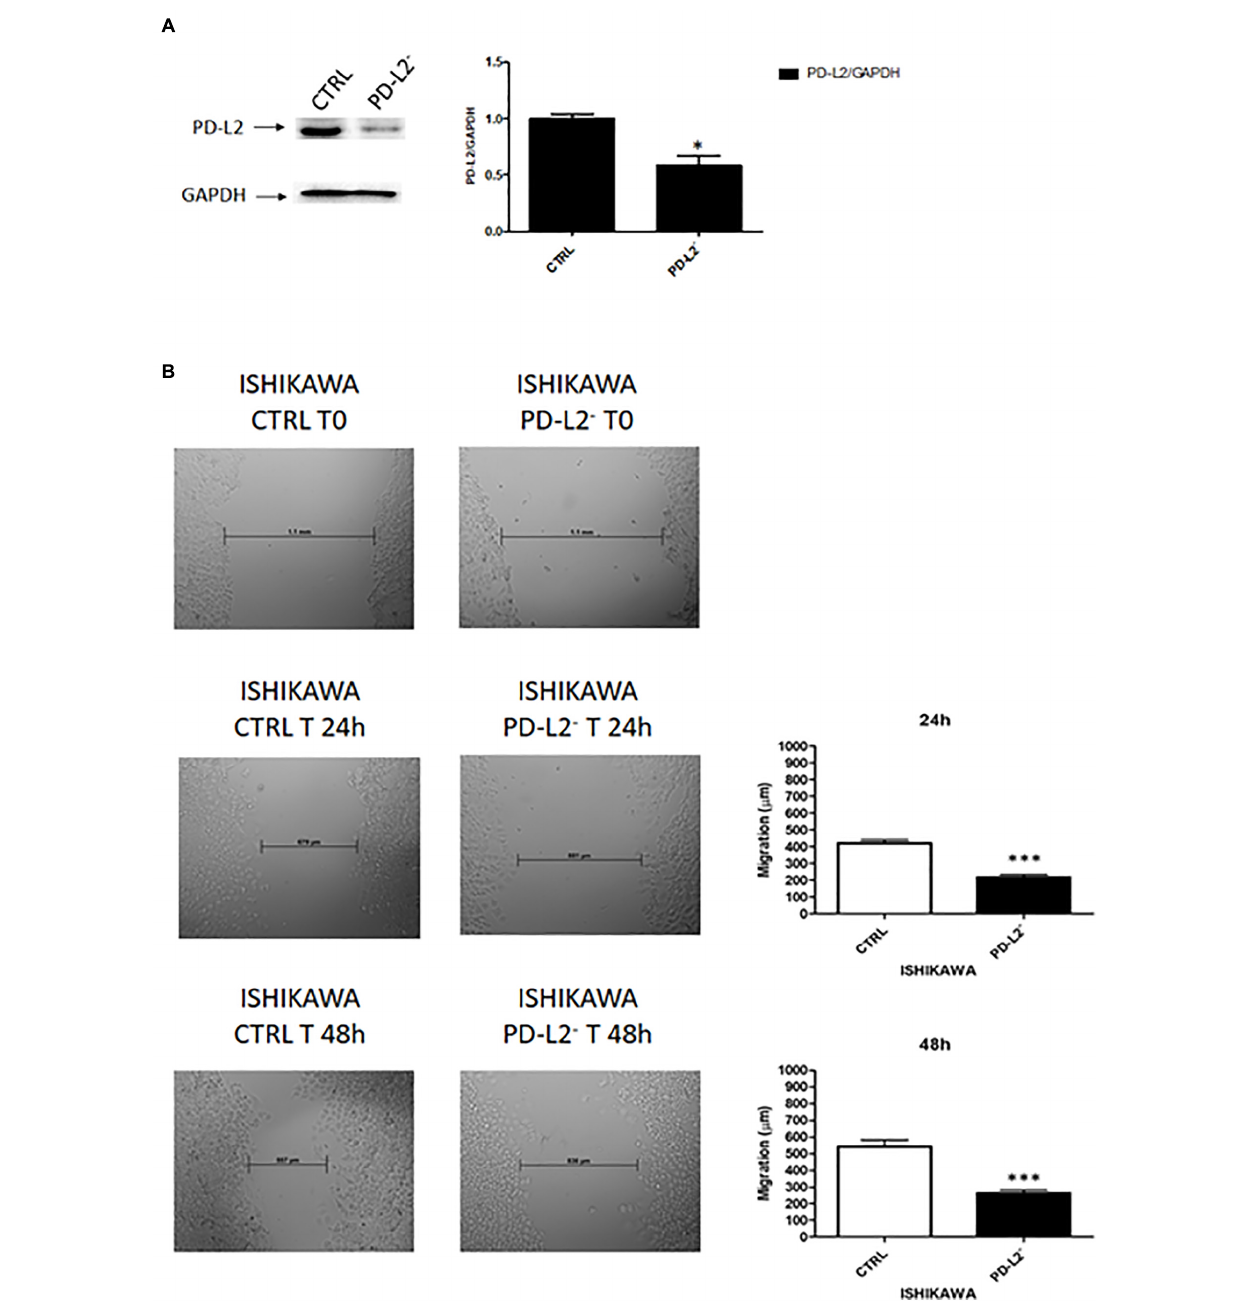
FIGURE 6 | (A) PD-L2 silencing reduces migration in Ishikawa cells. (A) Western blot analysis of PD-L2 and GAPDH protein levels in PD-L2–Ishikawa cells. Blots are representative of one of three separate experiments. PD-L2 densitometry values were normalized to GAPDH used as loading control. Densitometric values shown are the mean ± SE of three separate experiments. * p < 0.05 vs control cells. (B) Wound healing assays for Ishikawa cells after PD-L2 silencing. All experiments were repeated three times. T0 h (used for consistency with other time-points). Data are presented as the mean ± SD. *** p < 0.001 vs